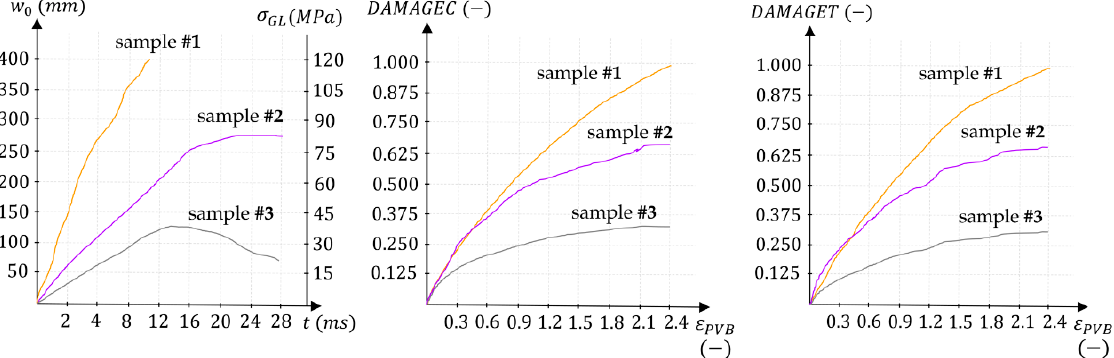
Figure 11. Comparison of the results of numerical simulations for the destruction of the VSG wall with PVB spacers for sample #1 , sample #2 , and sample #3 .